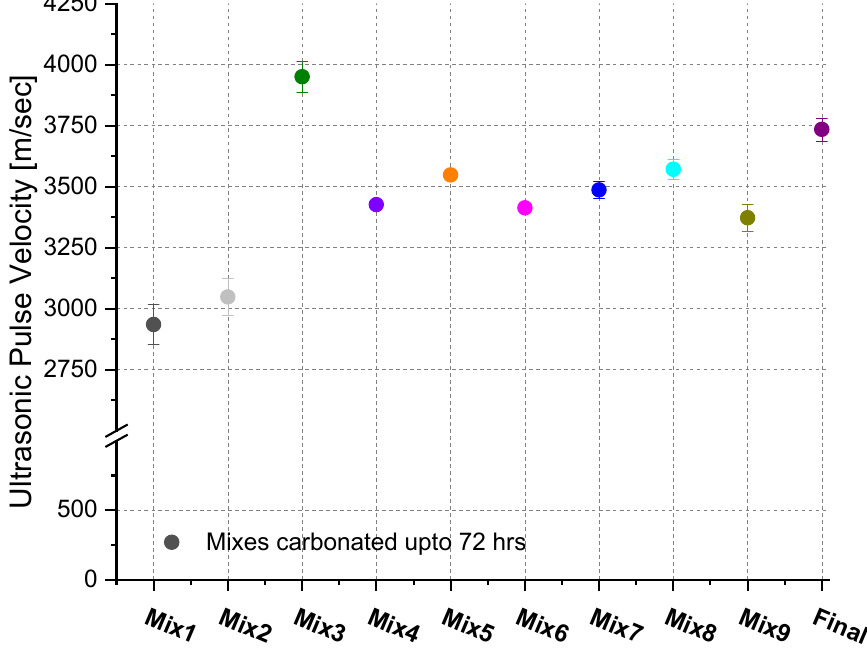
Figure 6. Ultrasonic pulse velocity of pavers up to 72 h of carbonation.